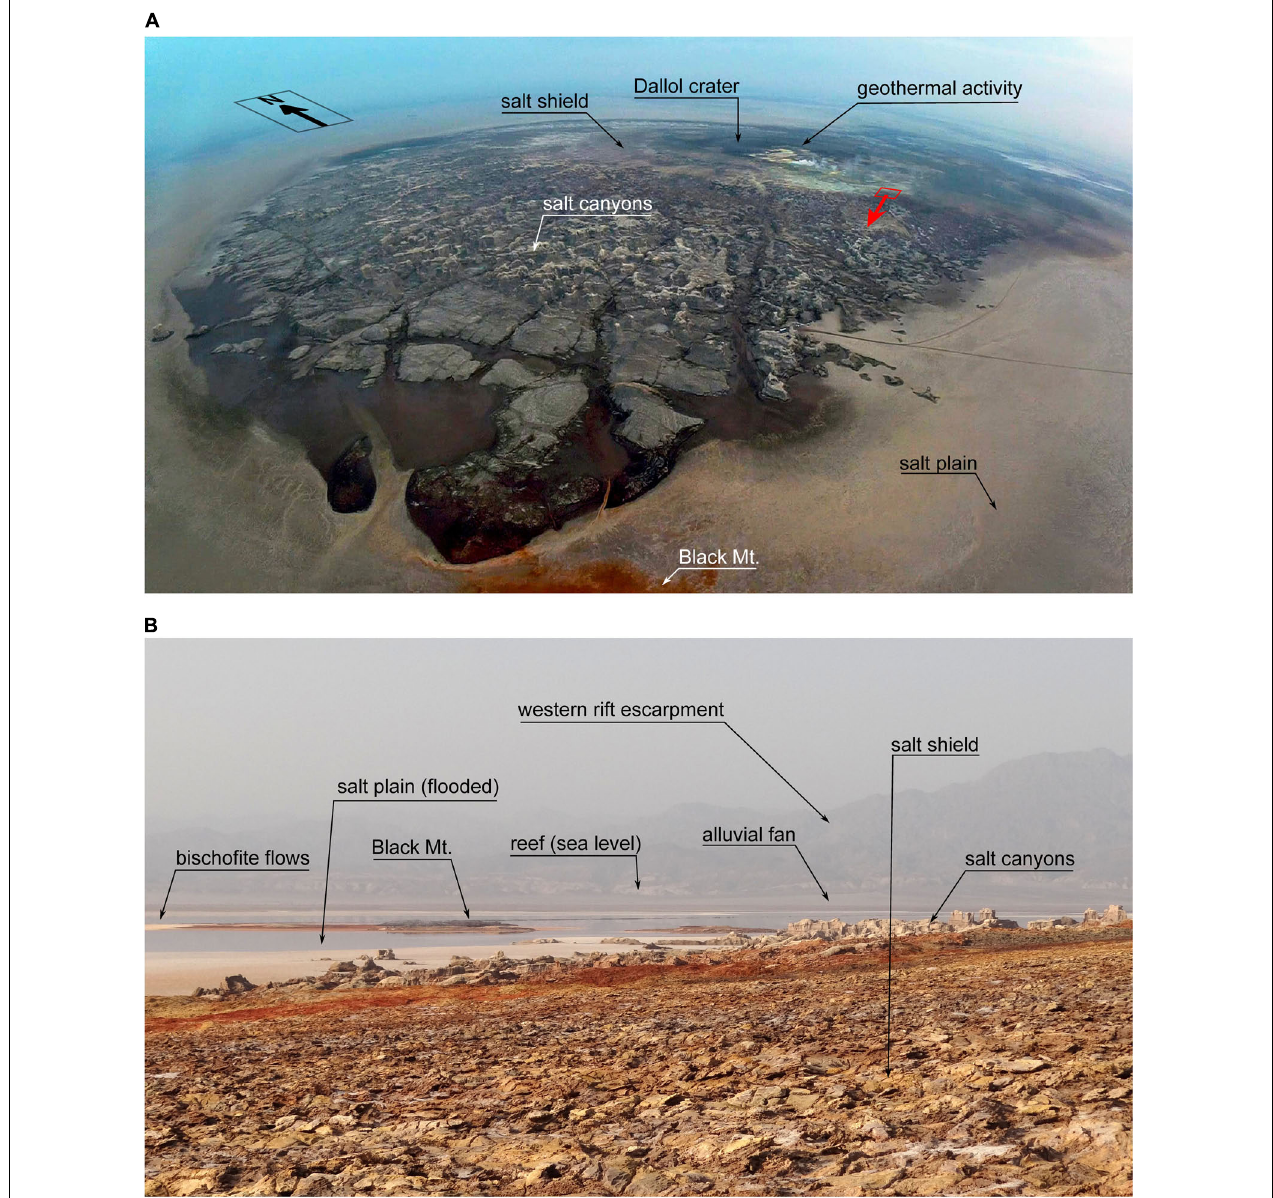
FIGURE 7 | Aerial view of the Dallol dome. (A) View taken from the vertical of the Black Mountain to the northeast. (B) Opposite ground image taken from the top of the dome to the southwest.